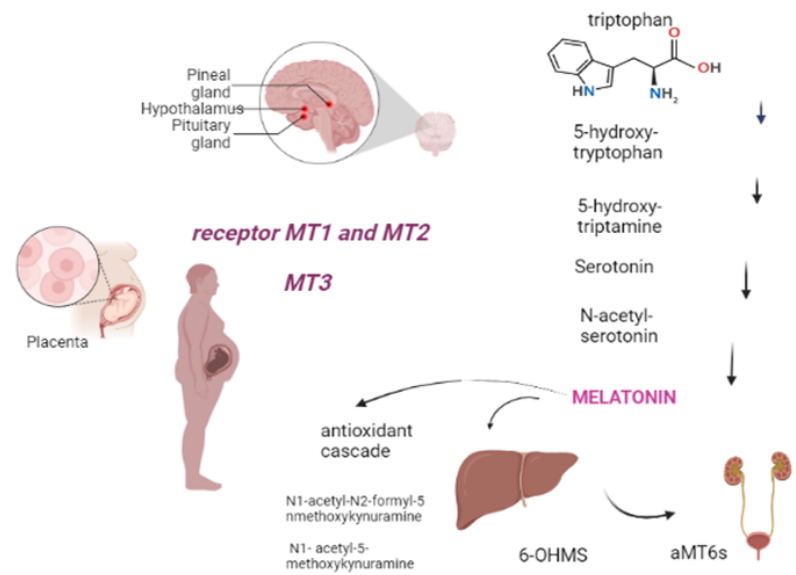
Figure 1. Melatonin comes from tryptophan, produced in the pineal gland after five stages of chem- ical reaction. It is subsequently metabolized in the liver and kidney or non-enzymatically (antioxi- dant cascade). Tissue targets include, during pregnancy, the placenta through the MT1, MT2 and MT3 receptors (Created with BioRender.com on 1 January